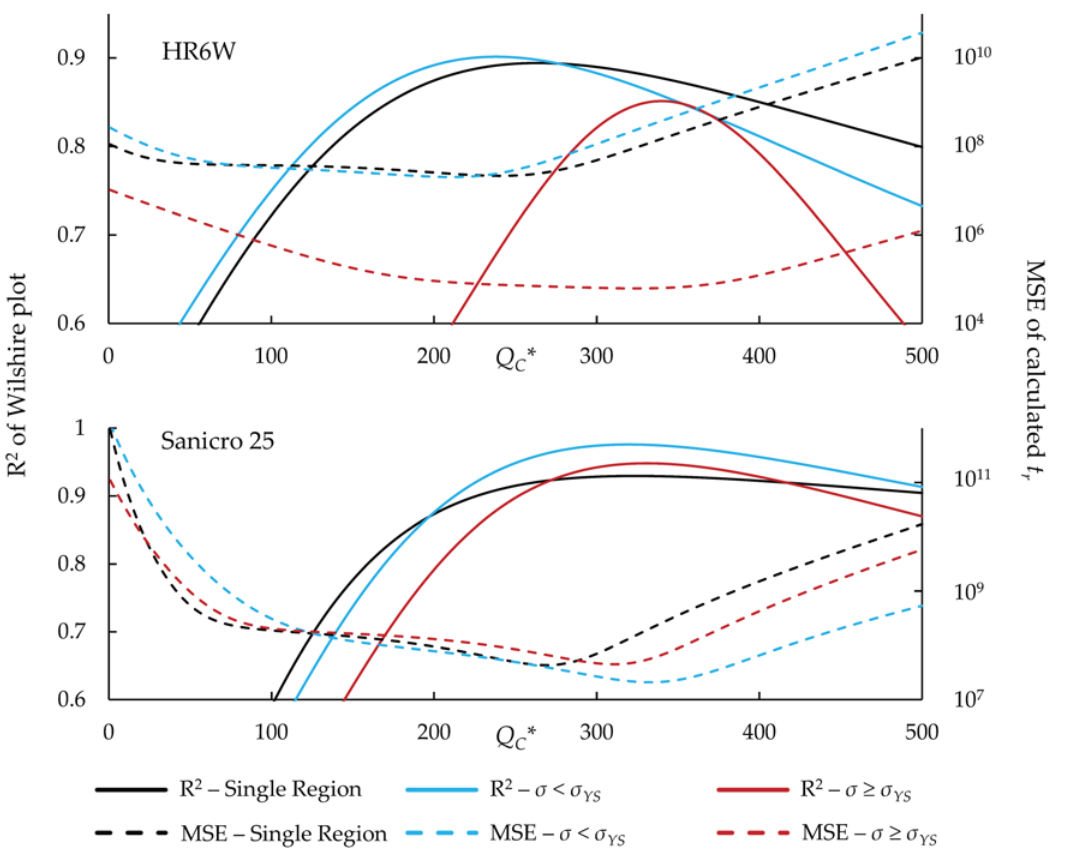
Figure 4. R 2 and MSE versus Q ∗